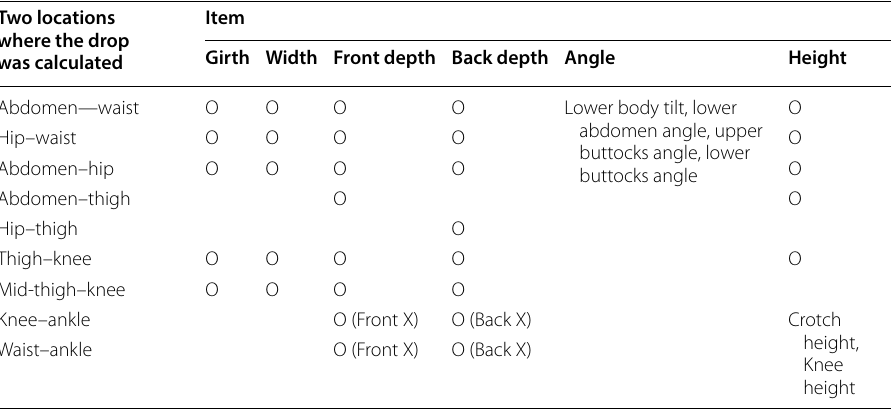
Table 1 Variables used for statistical analysis Two locations where the